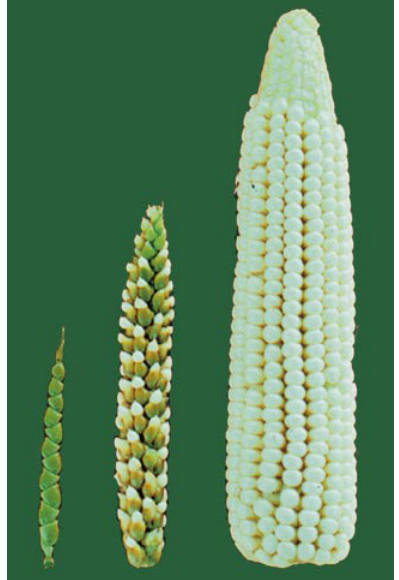
Figure 1. Crossing for Kernels Over time, selective breeding modifies teosinte’s few fruitcases (left) into modern corn’s rows of exposed kernels (right). (Photo courtesy of John